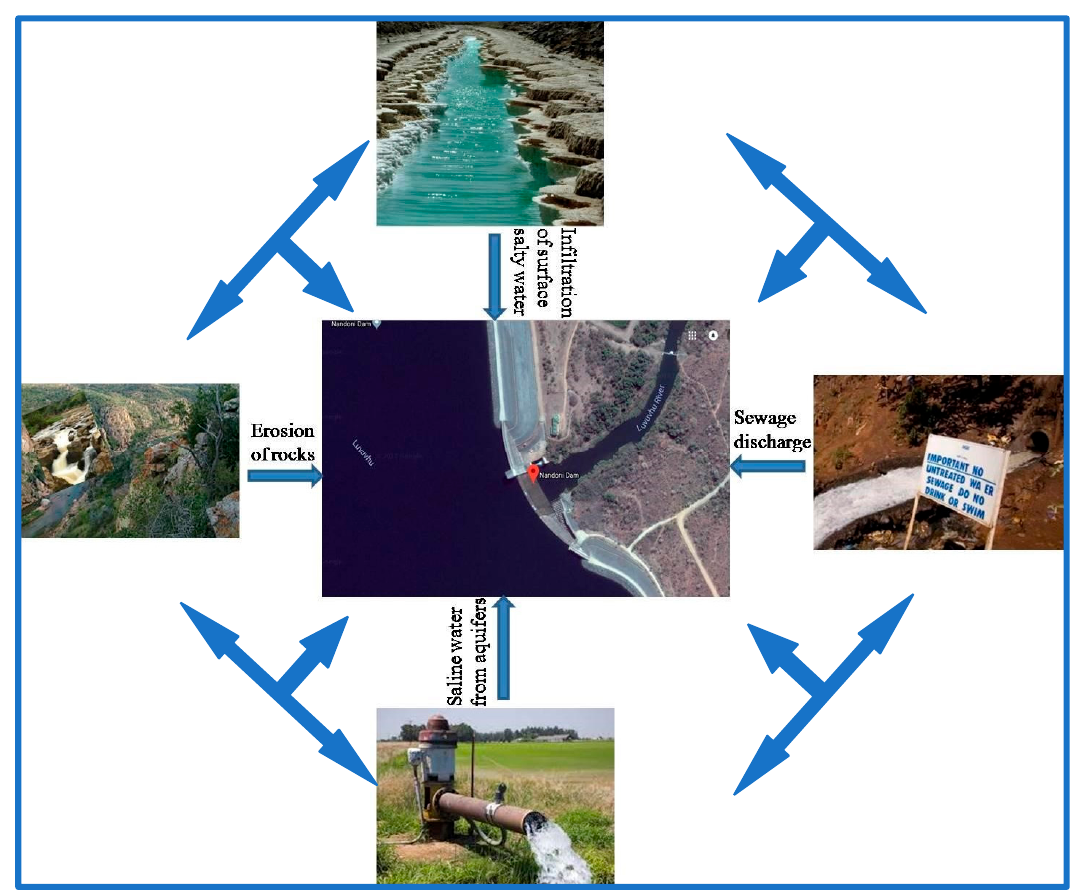
Figure 3 . Possible sources of water salinity in the Nandoni Dam. Figure 3. Possible sources of water salinity in the Nandoni